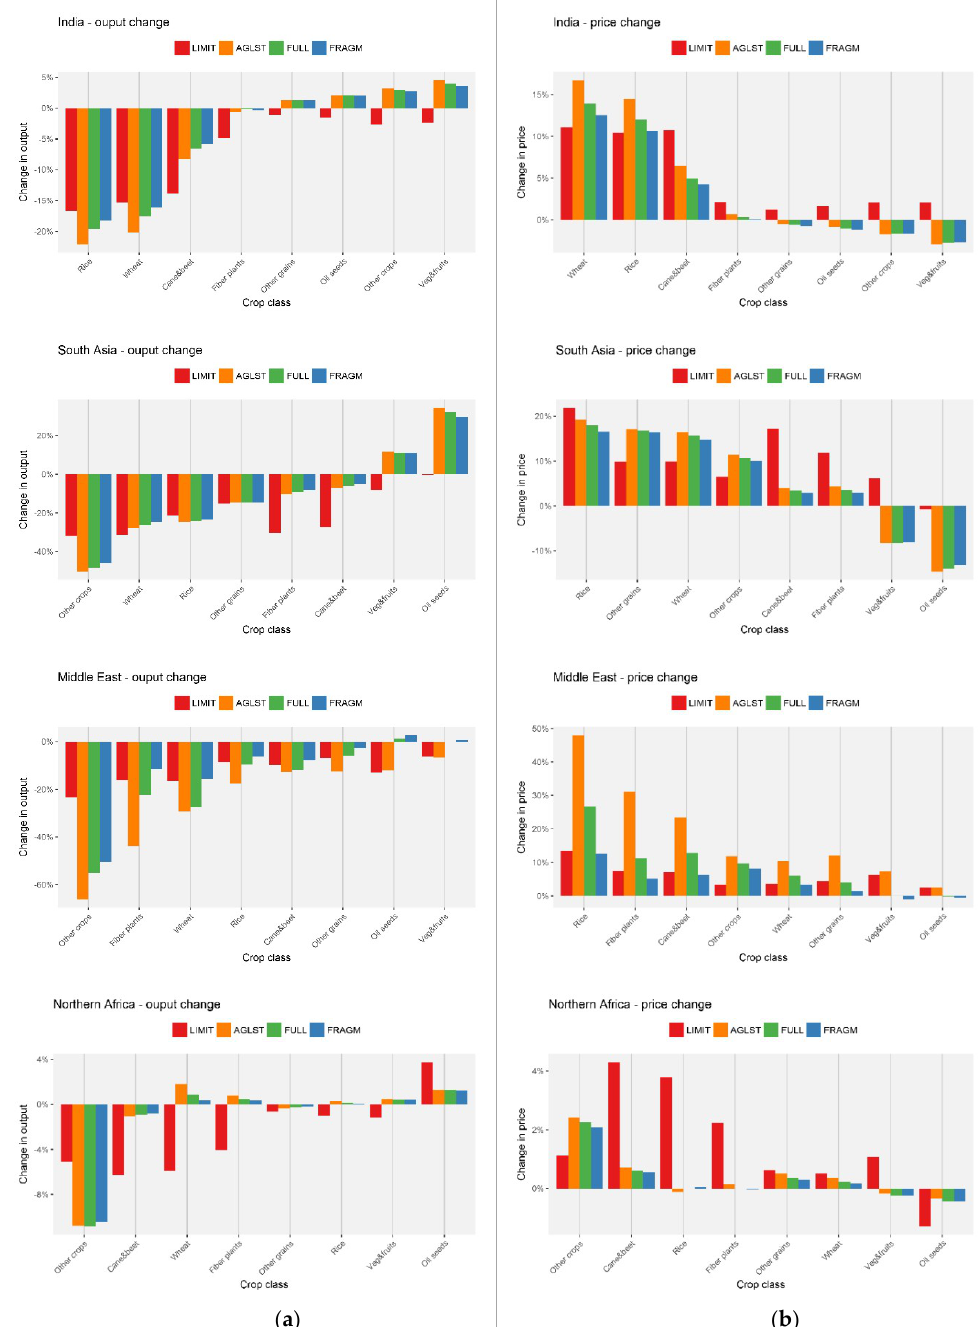
Figure 7. Water scarcity impacts on crop production. ( a ) Crop output change by region. ( b ) Crop price change by region.